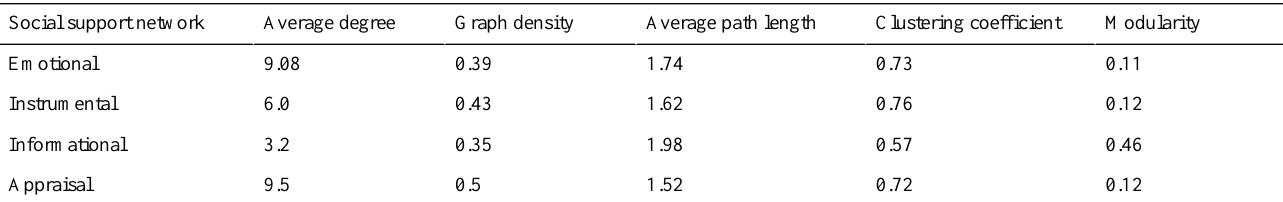
Table 1. Summary of social network metrics for Second Life Impacts Diabetes Education & Self-Management (SLIDES) social support networks.